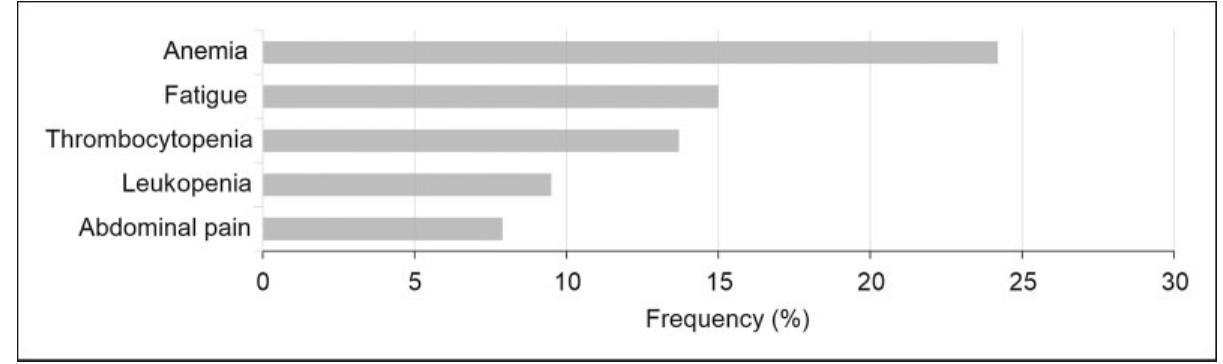
Fig. 1 Symptoms and signs typical for paroxysmal nocturnal hemoglobinuria in a cohort of 150 children with con fi rmed thrombosis treated